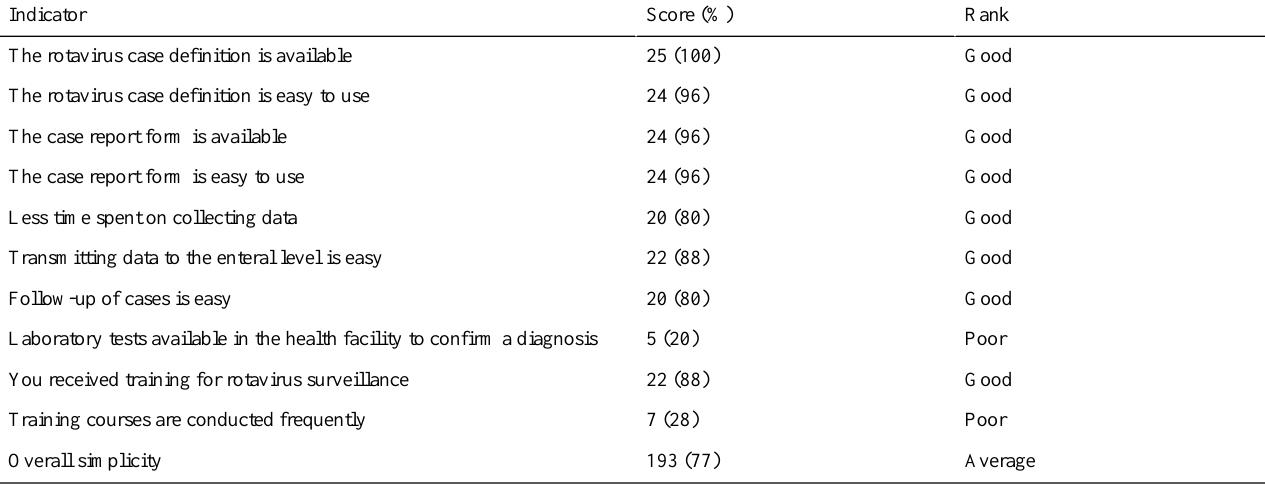
Table 4. The scores (score percent, %) and rank of the simplicity indicators as assessed by the sentinel site coordinators.